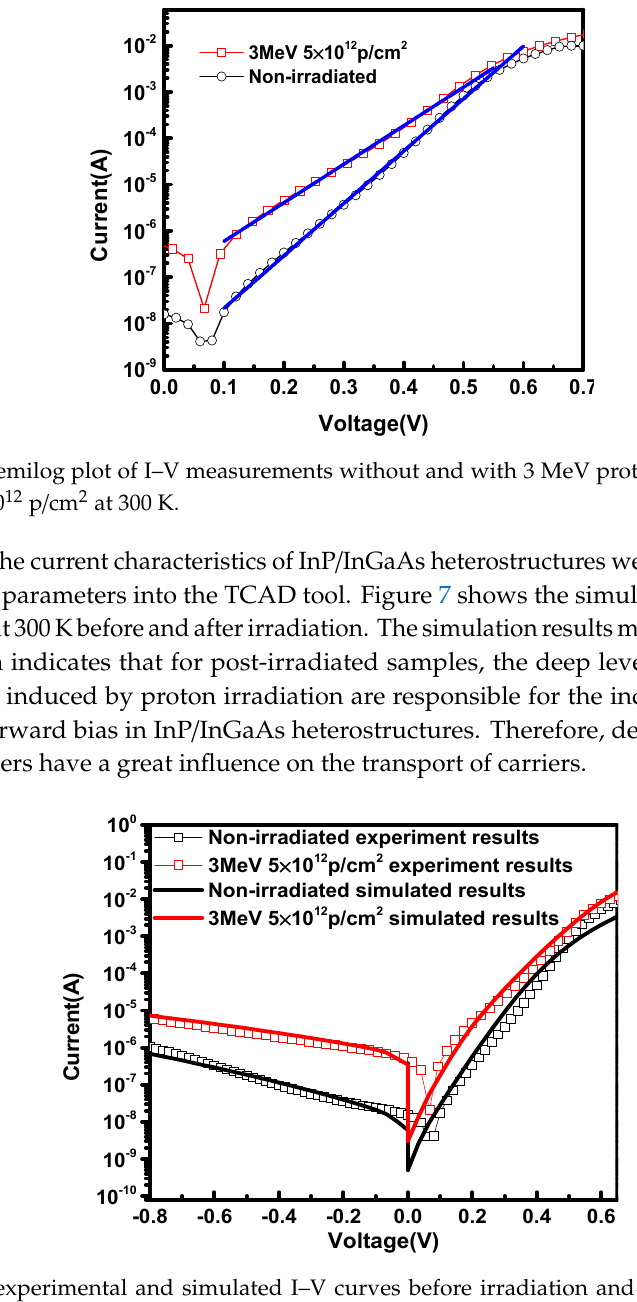
Figure 7. The experimental and simulated I–V curves before irradiation and after 3 MeV proton irradiation in InP/InGaAs heterostructures.